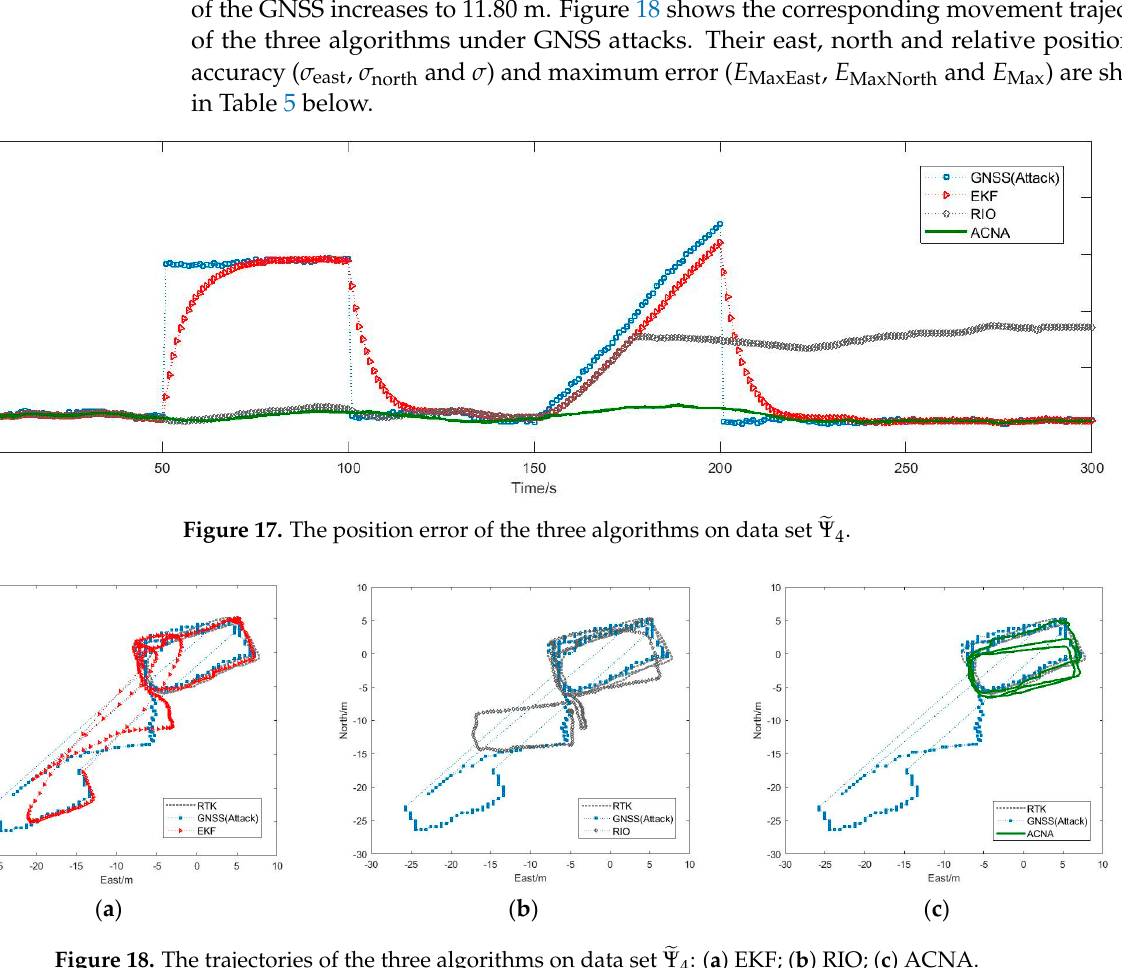
Figure 18. The trajectories of the three algorithms on data set (cid:101) Ψ 4 : ( a ) EKF; ( b ) RIO; ( c ) ACNA.